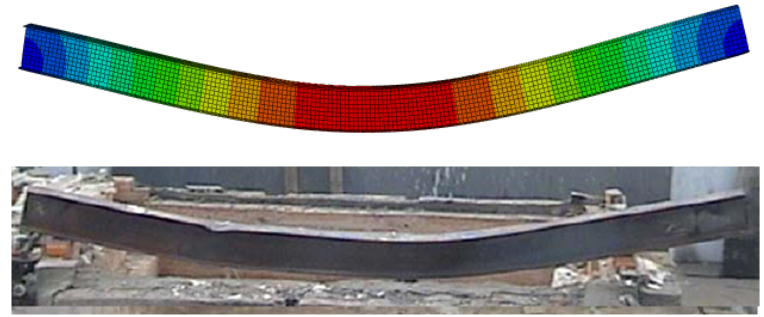
Figure 16. The comparison between the simulation and the experiment.